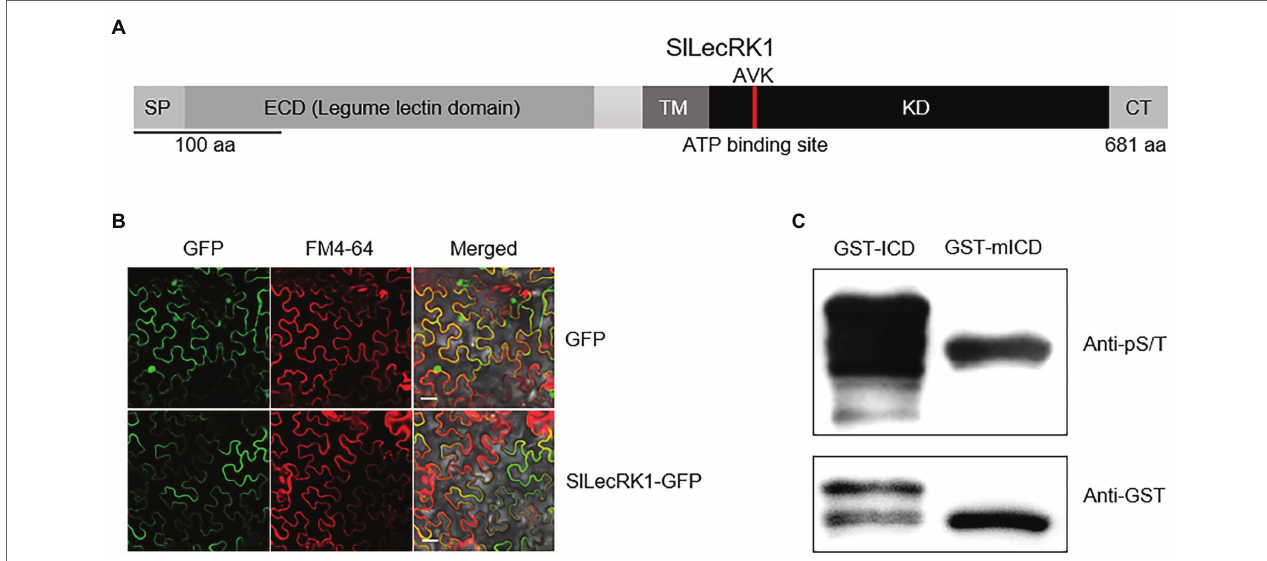
FIGURE 2 | Characterization of SlLecRK1. (A) Diagram of the functional domains in SlLecRK1. SP, signal peptide; ECD, extracellular domain; TM, transmembrane domain; KD, kinase domain; CT, C-terminal region. The red bar in the KD marks the AVK motif (the ATP-binding site). (B) Confocal microscopic images of SlLecRK1Pro:SlLecRK1-GFP transiently expressed in N. benthamiana leaves. FM4-64 was used as a marker for the plasma membrane. Bars, 20 μ m. (C) Immunoblot analysis of GST-ICD and GST-mICD recombinant proteins using antibodies specific for serine and threonine phosphorylation (pS/T). Anti-GST antibodies were used as a loading